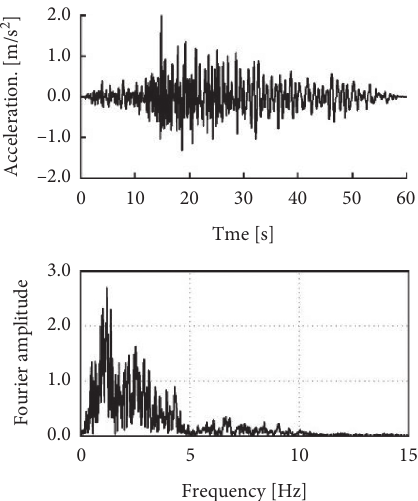
Figure 4: Ground motion acceleration of Chuetsu-oki and its Fourier amplitude